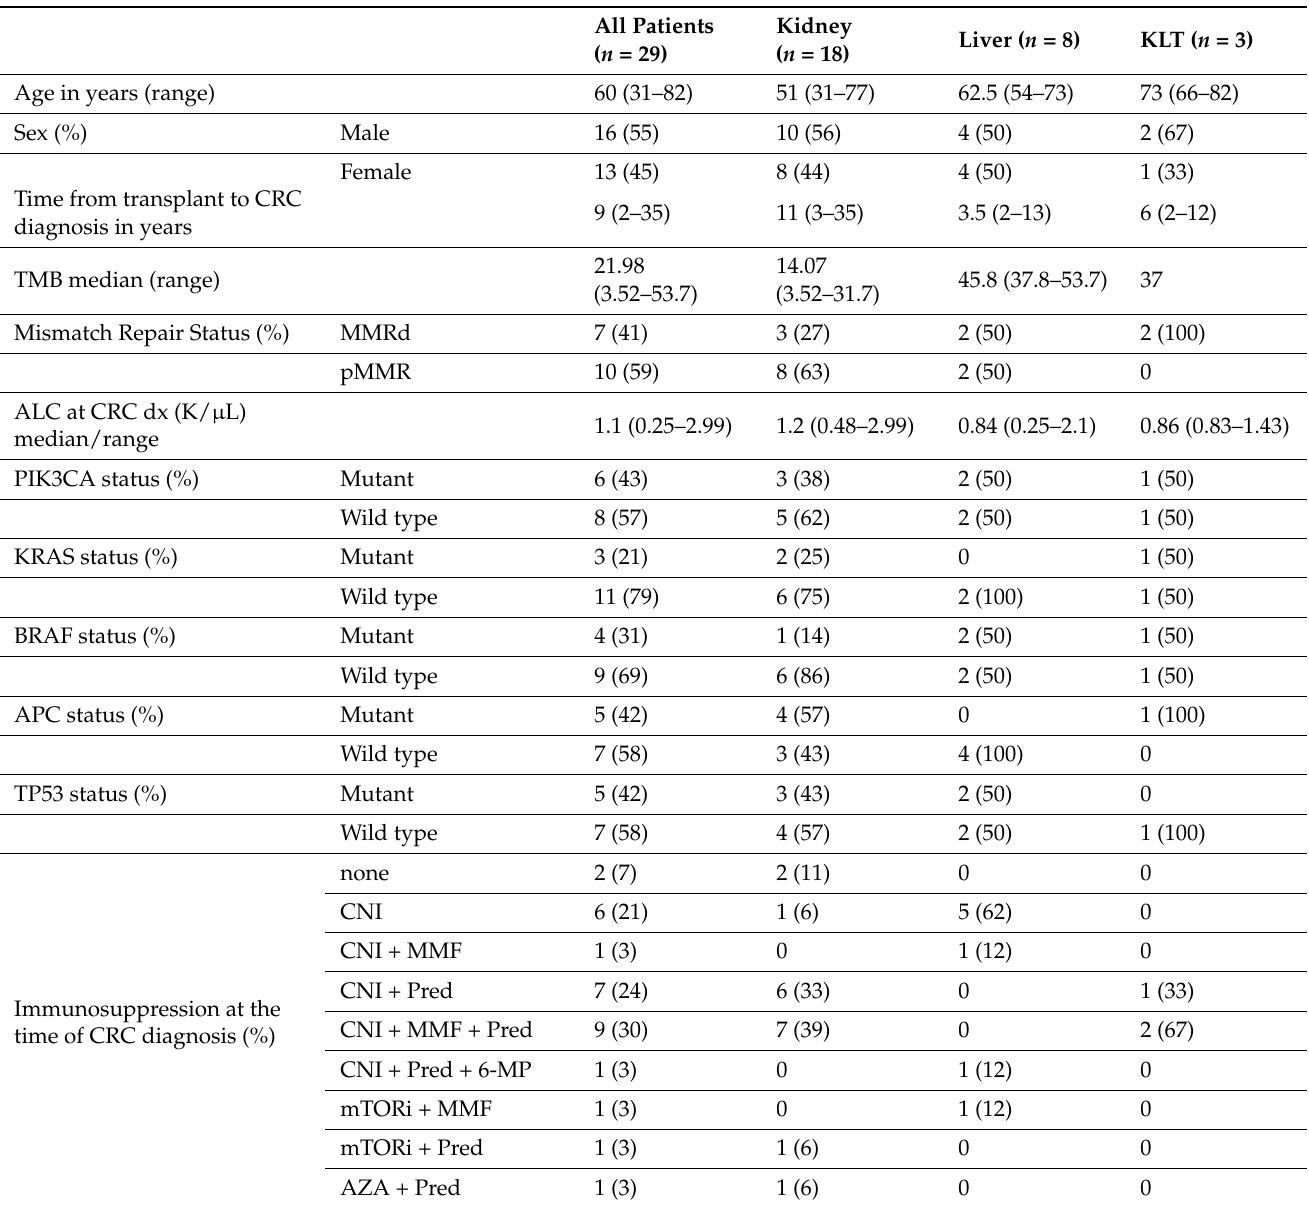
Table 1. The demographics of Post-Transplant Patients that Developed Colorectal Cancer. All